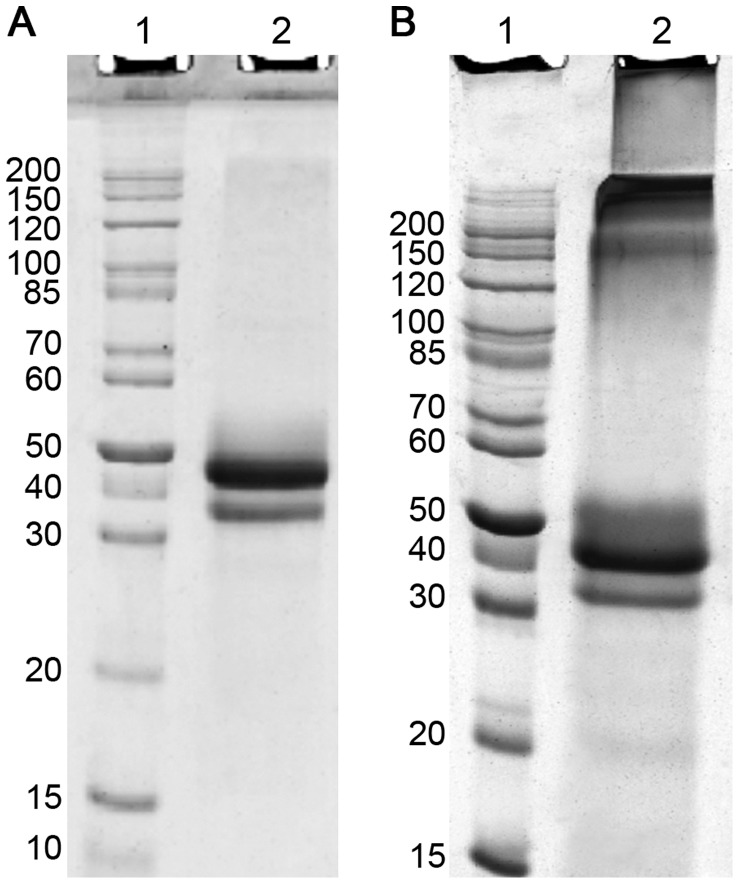
Images of Coomassie blue stained SDS-PAGE gels analysing b-rCLU.(A) Lane 1: Molecular weight markers with size indicated in kDa. Lane 2: Sample of b-rCLU after SEC purification in solubilisation buffer containing 8 M urea and 5 mM DTT. (B) Lane 1: Molecular weight markers with size indicated in kDa. Lane 2: Sample of b-rCLU after step-wise dialysis into PBS/Az.